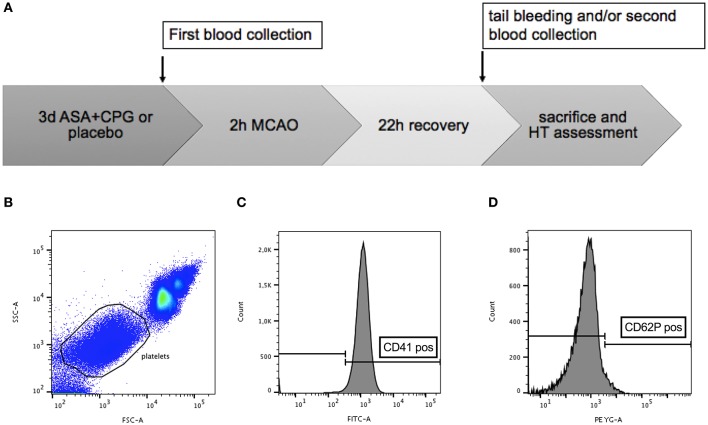
(A) Timeline diagram of the experimental procedures: platelet function in control and ASA+CPG mice was tested in vitro using flow cytometry at the end of 3 days pretreatment. Mice were subjected to 2 h MCAO and tPA administration. Twenty-two hours later, tail bleeding tests and a second flow cytometry analysis were performed, followed by sacrifice and histological assessment of hemorrhage. (B–D) Gating strategy: Ungated whole blood (B). Gated cells scored high for platelet identification marker FITC-CD41 (C) and low for the platelet activation marker PE-CD62P (D), consistent with the properties of resting platelets (Analysis performed with FlowJo).